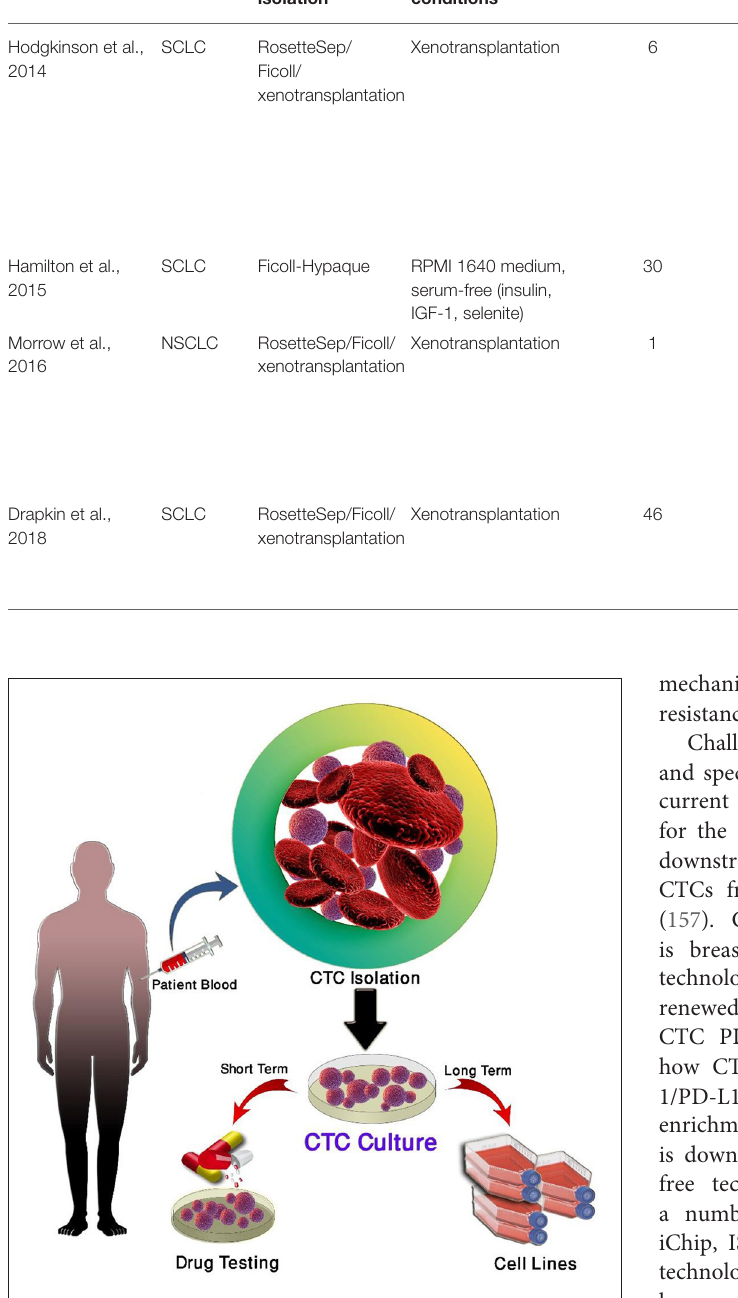
FIGURE 1 | Culture of circulating tumor cells.